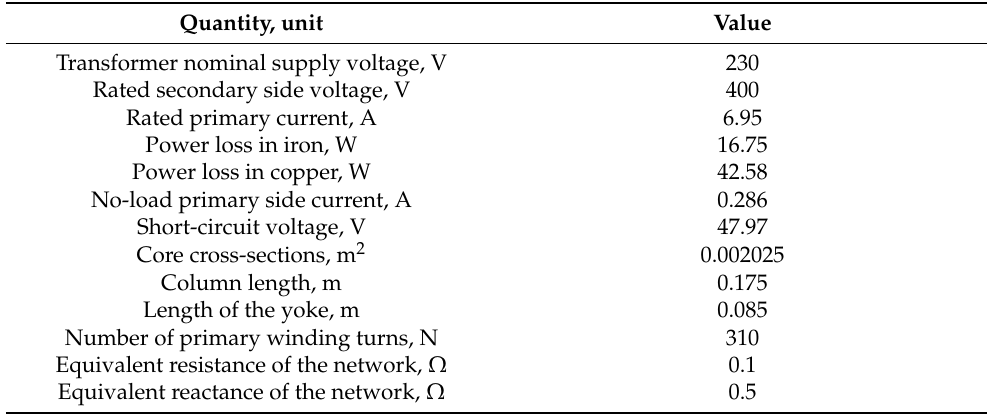
Table A2. Manufacturing data of the modeled Breve TUM 1600/A 230/400V transformer. Quantity,